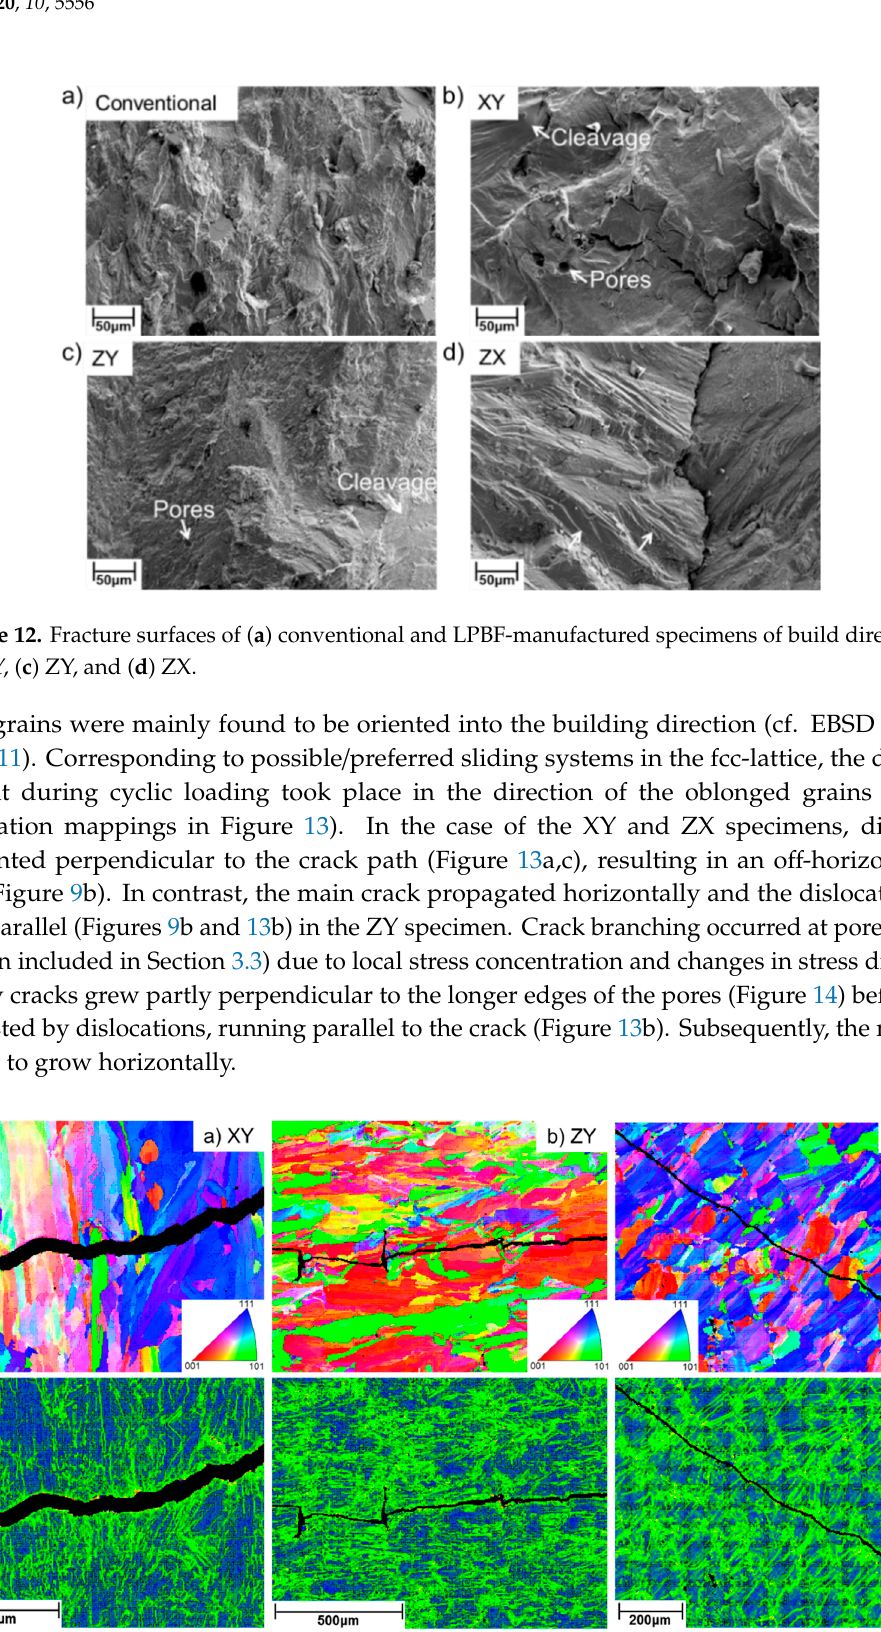
Figure 13. EBSD and local misorientation mappings of additively manufactured specimens referring to the build directions ( a ) XY, ( b ) ZY, and ( c ) ZX.